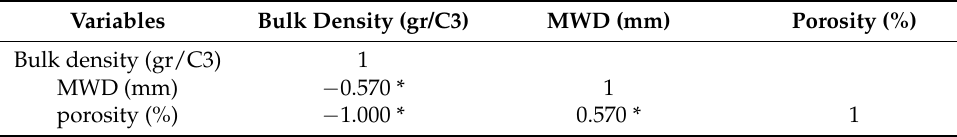
Table 10. Correlation matrix of the soil physical characteristics.